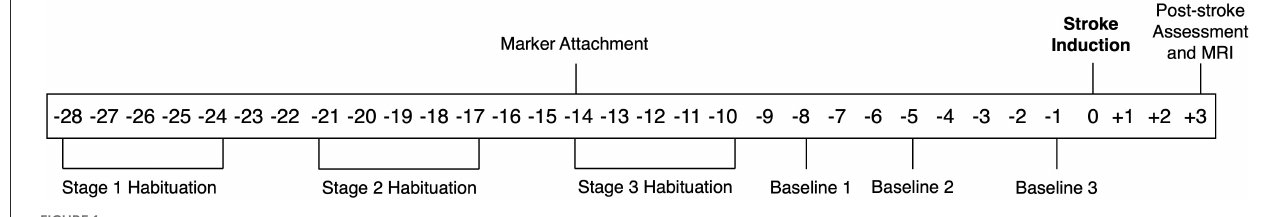
FIGURE1 Experimental timeline. Animals arrived at the facility 6 months prior to stroke induction. Thereafter procedures commenced 4 weeks prior to stroke (where stroke induction is indicated as day 0) including staged habituation, palpation and marker attachment, baseline assessments, post-stroke assessment, and